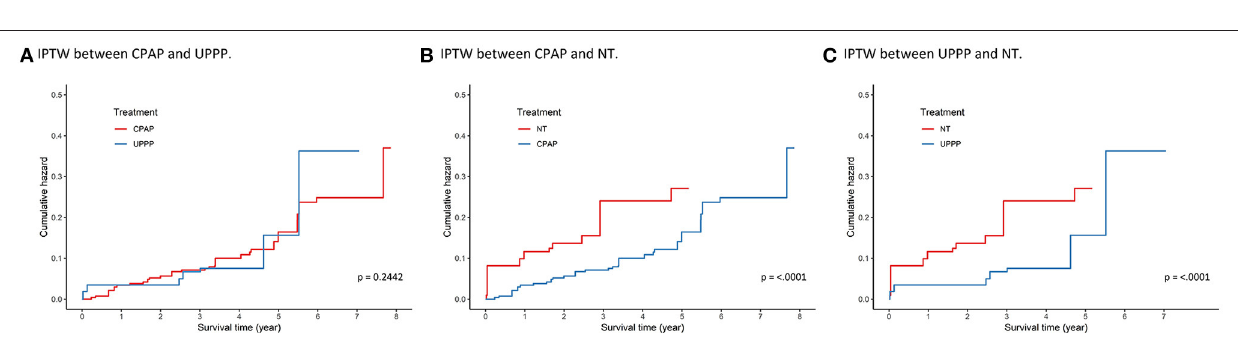
FIGURE 3 | Survival analysis using IPTW between (A) CPAP group and UPPP group, (B) CPAP group and NT group, and (C) UPPP group and NT group. Age, gender, BMI, RDI, index year, and comorbidities status of DM, CKD, CVDs, and HLD were used to calculate the weighting. The Bonferroni significant level is 0.0167. The significances were found in (B) and (C) ( p < 0.001). IPTW, inverse probability of the treatment